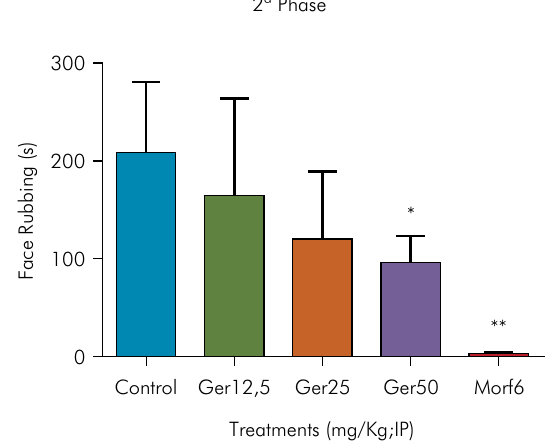
Figure 2. Effect of geraniol on capsaicin-induced nociception. Control (0.2% Tween 80); geraniol (12.5, 25 and 50 mg/kg IP); morphine (6 mg/kg IP). Values are expressed as the mean ± SD (n = 7 in each group), p* = 0.003; P** = 0.01; p*** = 0.001 versus control (one-way ANOVA followed by the t-test for heterogeneous variances).